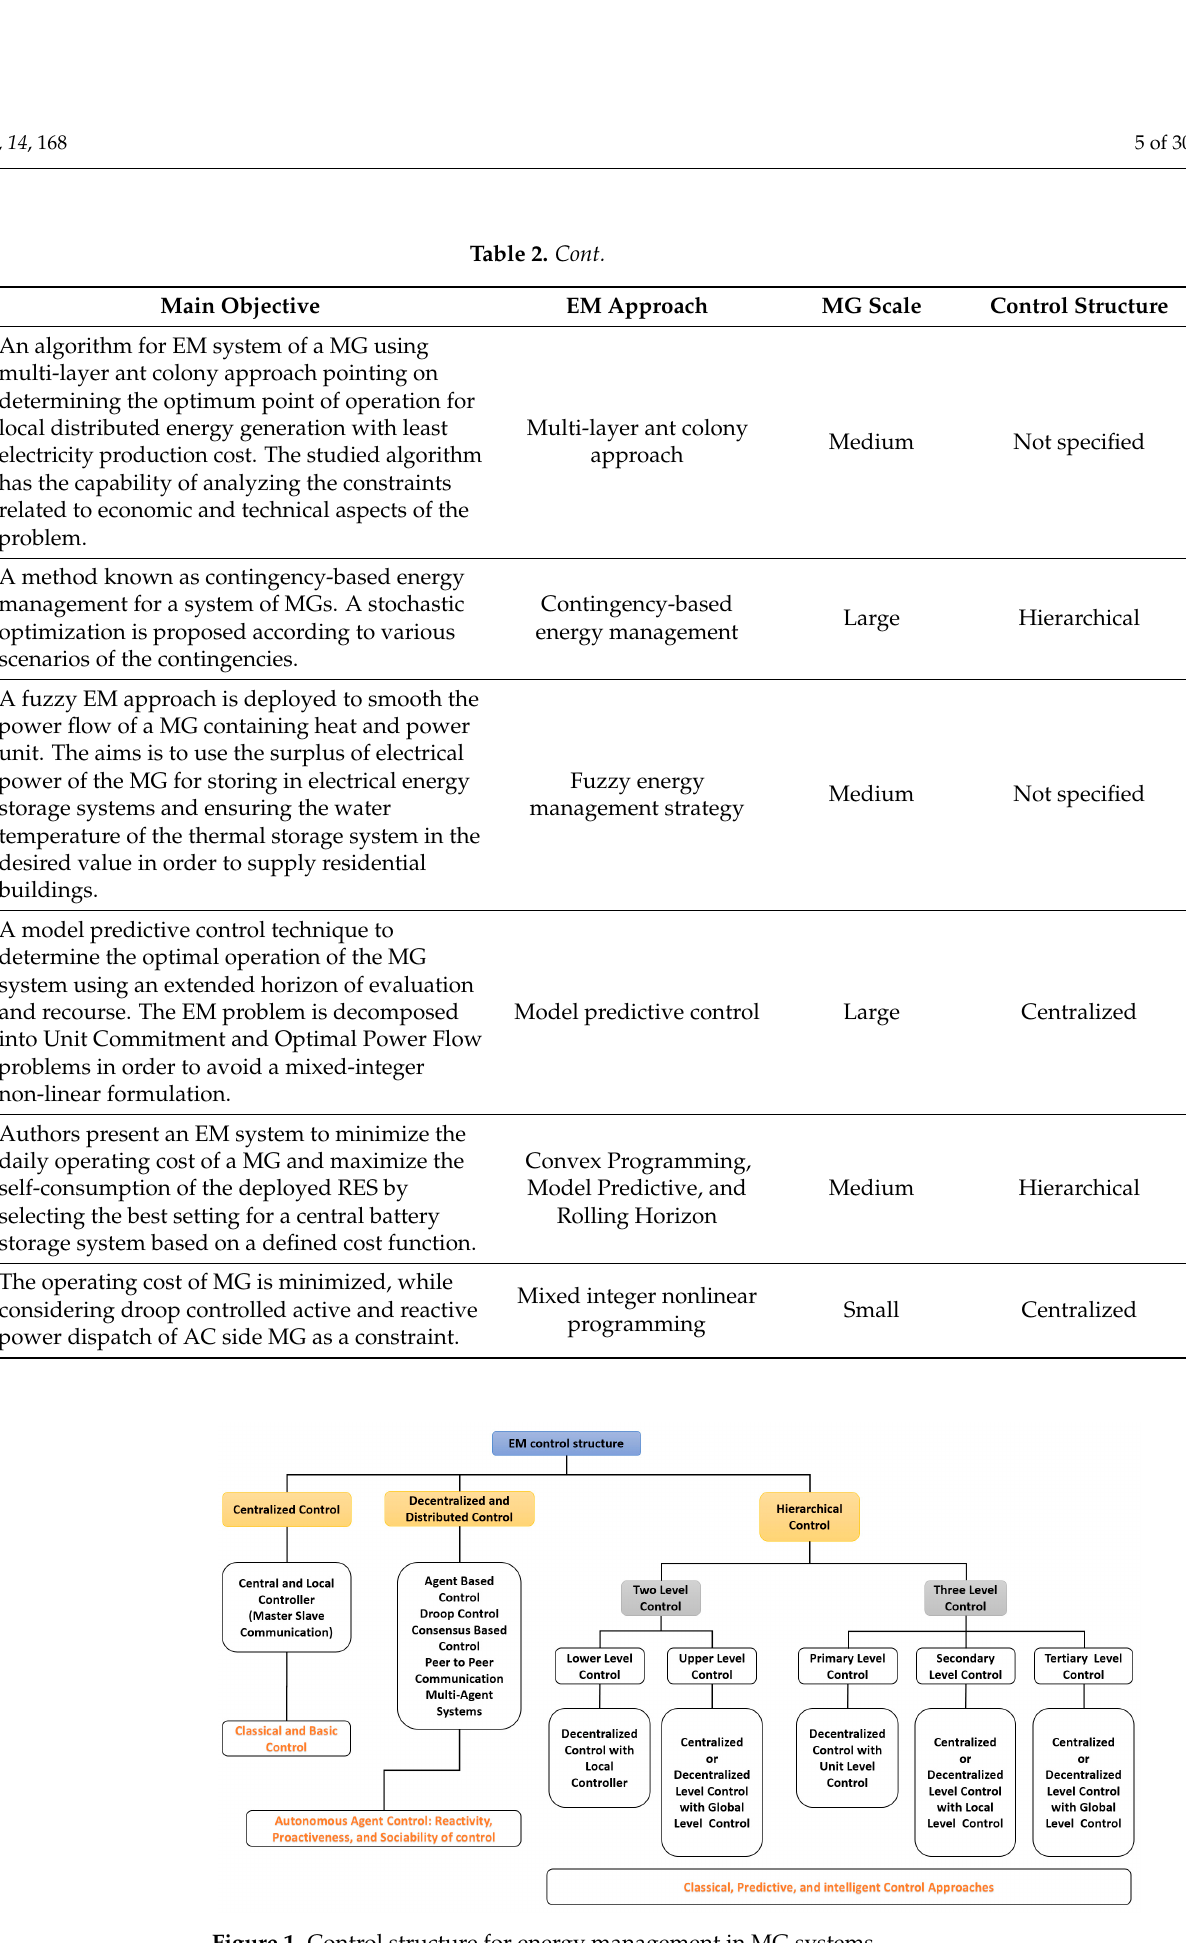
Figure 1. Control structure for energy management in MG systems.